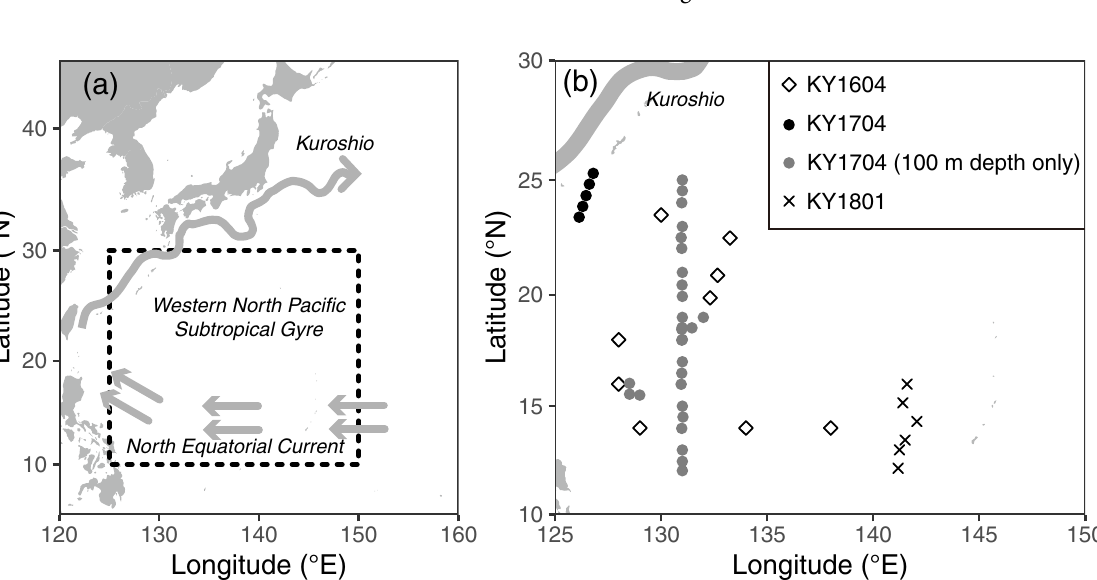
Fig 1. Sampling locations of this study. (a) Small-scale map of the western North Pacific, and (b) enlarged map of the sampling sites during the three cruises. The gray arrows in (a) denote schematic major ocean currents in the observation areas, but the Kuroshio current path is that of October 2017 based on the Quick Bulletin of Ocean Conditions issued by the Japan Coast Guard. (https://www1.kaiho.mlit.go.jp/